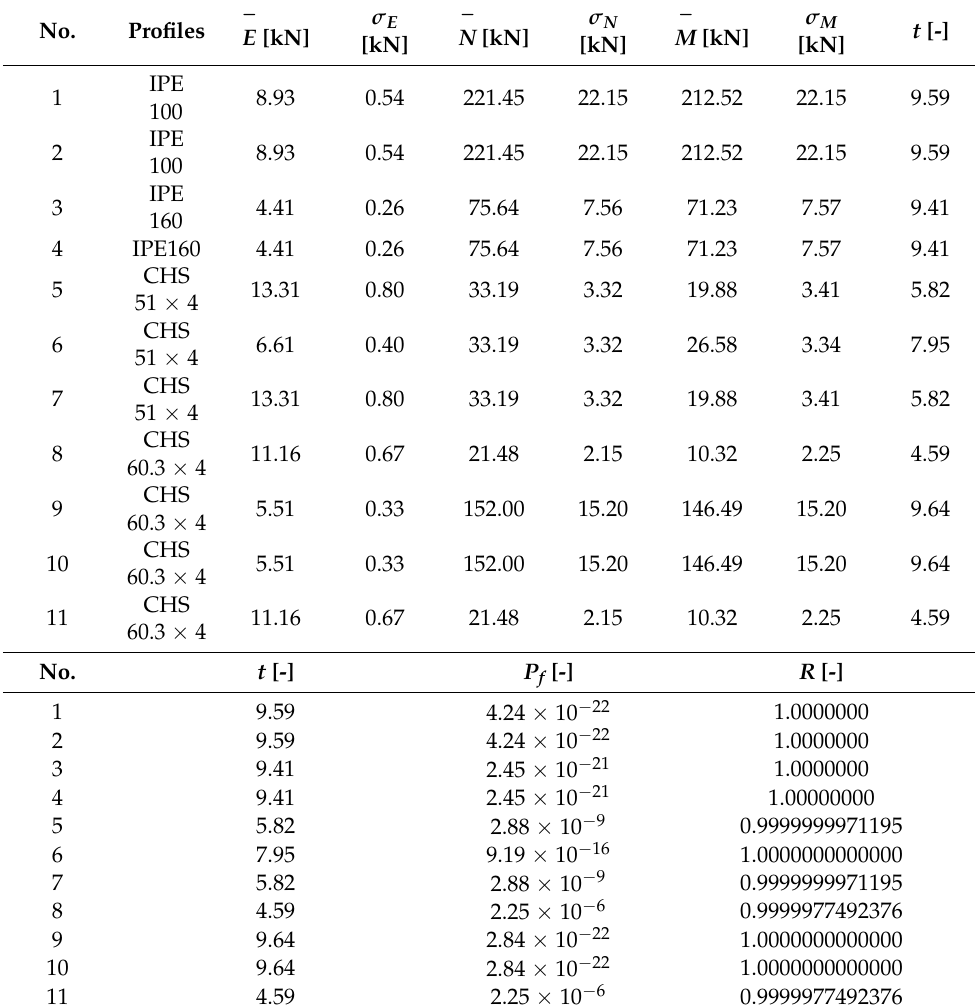
Table 2. The computation of a single element’s reliability in 0 min of fire duration (without tempera- ture